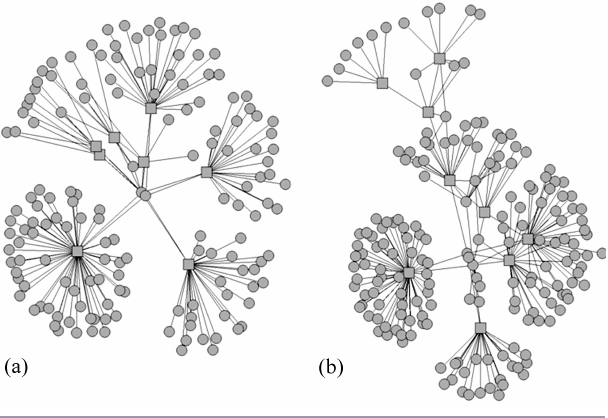
Fig. 5 . Graphical depiction of network data for (a) the 2001 black sigatoka outbreak and (b) the reconstructed Emergency Plant Pest Response Deed response. Squares indicate committees or working groups, and circles indicate individuals who participated in the response. Note that much of this information is considered sensitive; hence, the figure deliberately conceals